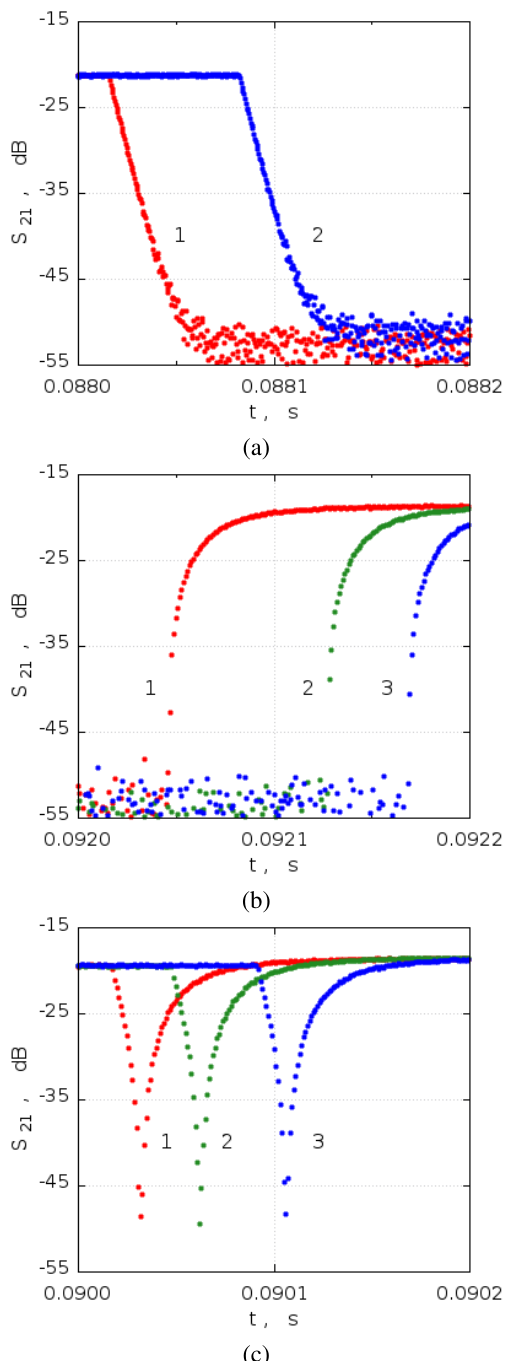
Figure 4: VNA signal measured in the time-domain at the resonant frequency f 0 when turning off the light in the case of (a) down, (b) up, and (c) hybrid switch in a setup with (a) WGM structure #1 ( f 0 = 4 . 268882 GHz, V LED =32V) and (b, c) WGM structure #3 ( f 0 = 6 . 231000 GHz, V LED =30.8V and 40.2V,